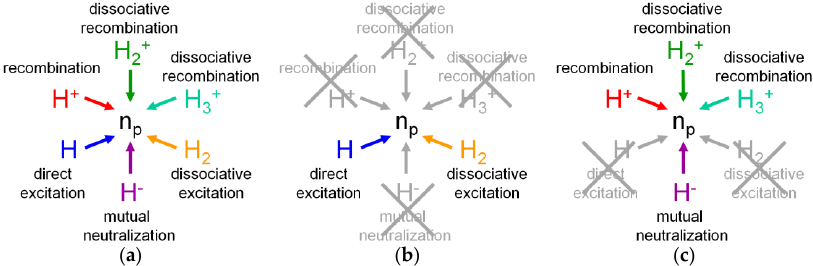
Figure 3. Excitation channels for atomic hydrogen included to the Yacora CR model for atomic hydrogen: ( a ) all channels; ( b ) channels relevant in ionizing plasmas; ( c ) channels relevant in recombining plasmas.